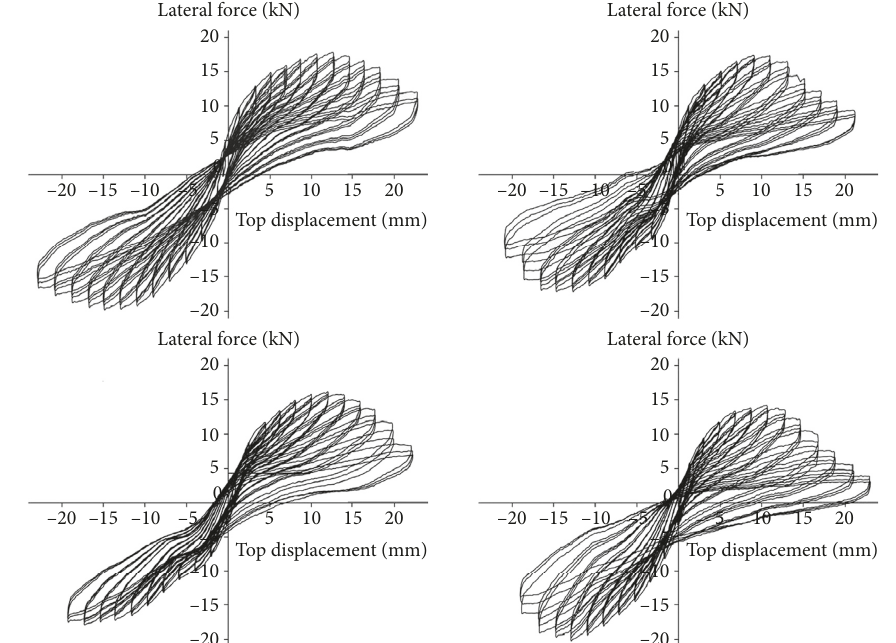
Figure 7: Hysteresis curves of reinforced air-entrained concrete column specimens: (a) Col-1; (b) Col-2; (c) Col-3; (d)